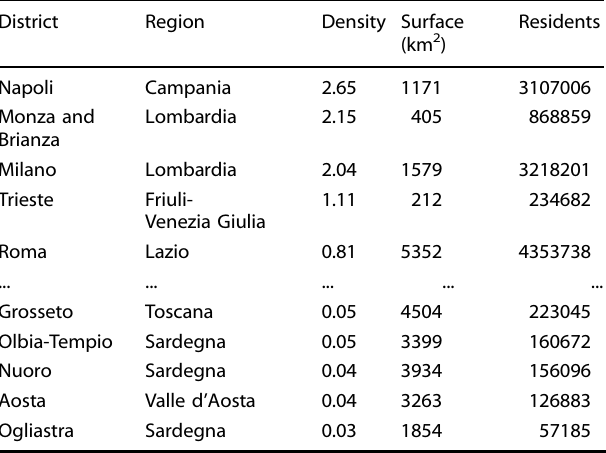
Table 3. Summary statistic of the fi ve most and least densely populated districts.